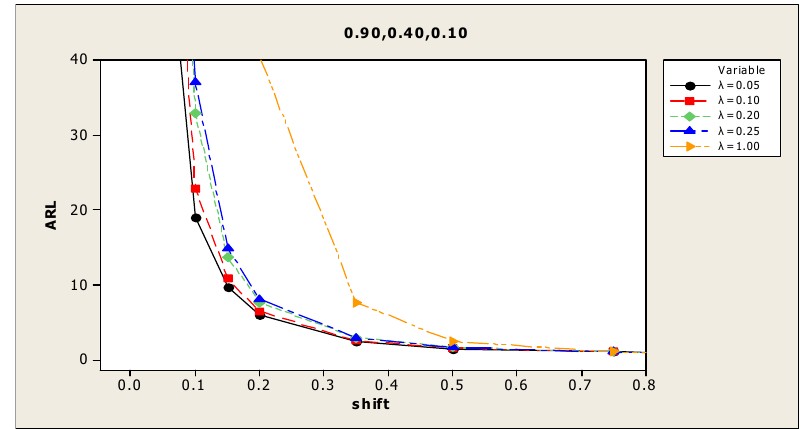
Figure 12. ARL curves when ρ yu = 0.9, ρ yv = 0.4, ρ uv = 0.1 at above values of λ